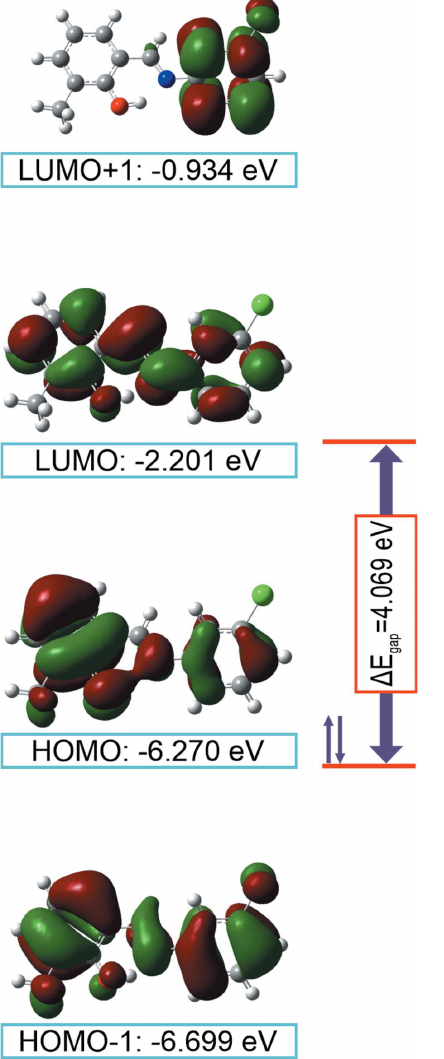
Figure 5 Molecular electrostatic potential (MEP) map calculated at the B3LYP/6– 311++G(2 d ,2 p ) level.